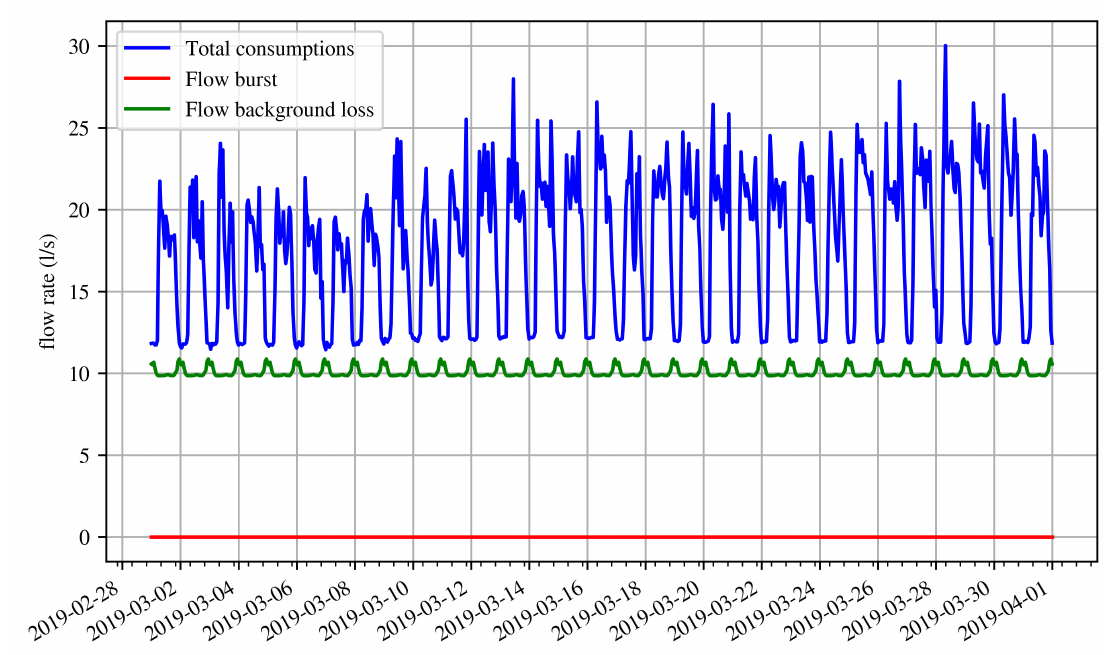
Figure 10. Total generated consumption of the Egna network for the March month, including the bursts and the calibrated background losses.